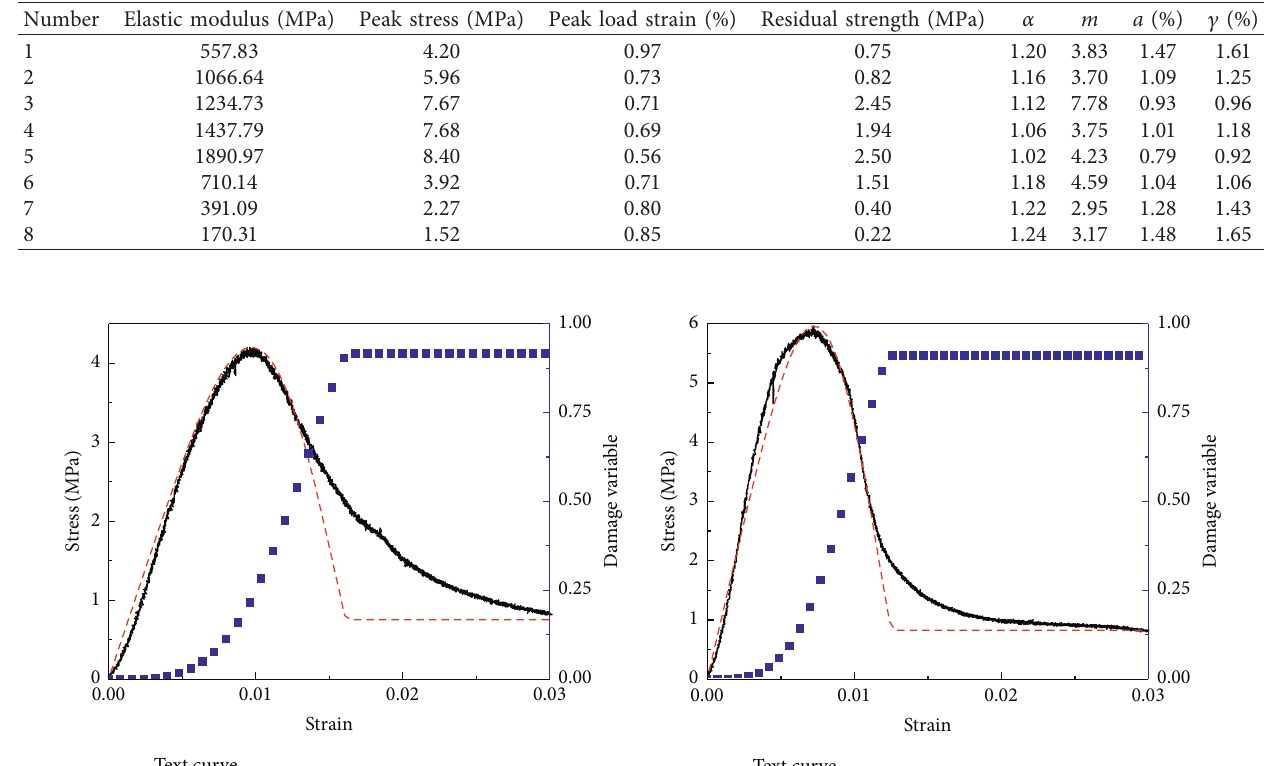
Table 2: Parameters of damage constitutive